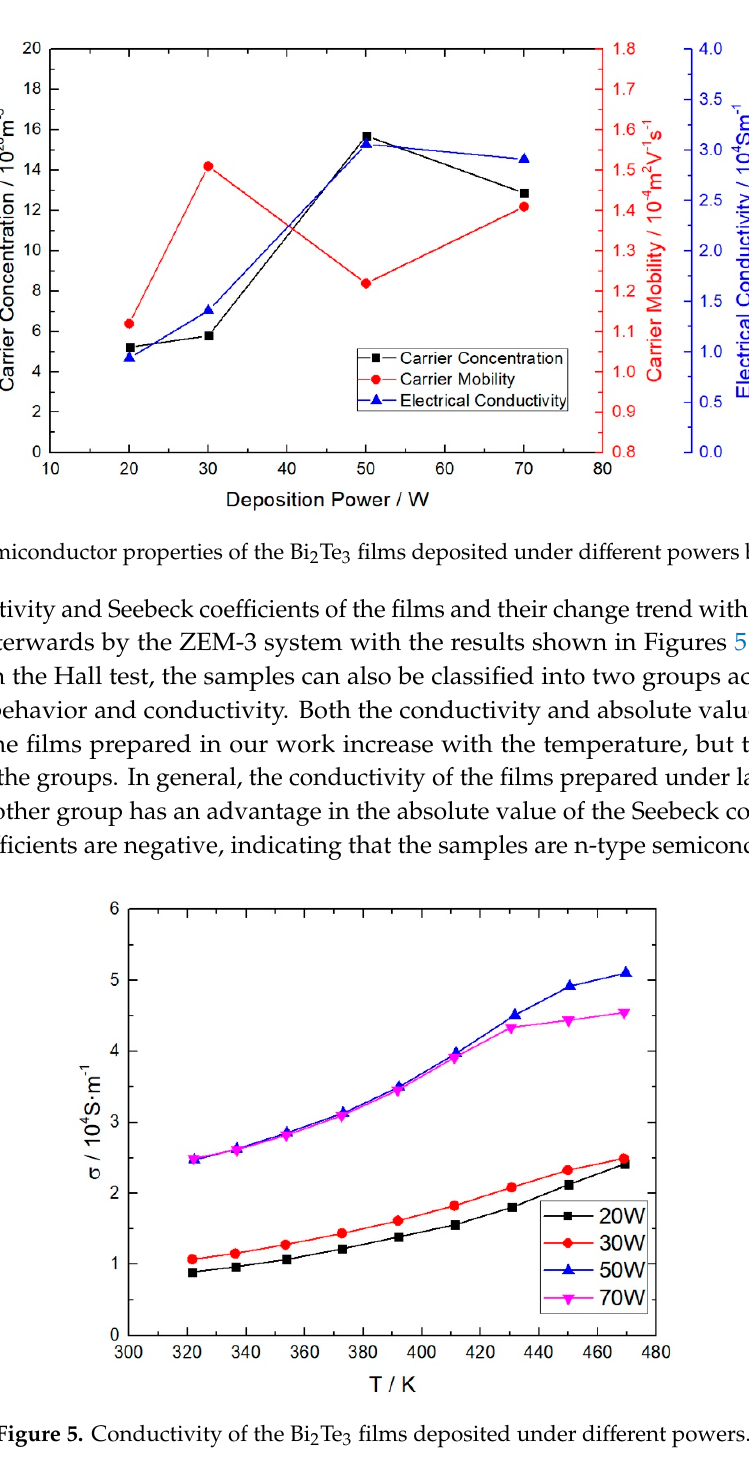
Figure 5. Conductivity of the Bi 2 Te 3 films deposited under different powers